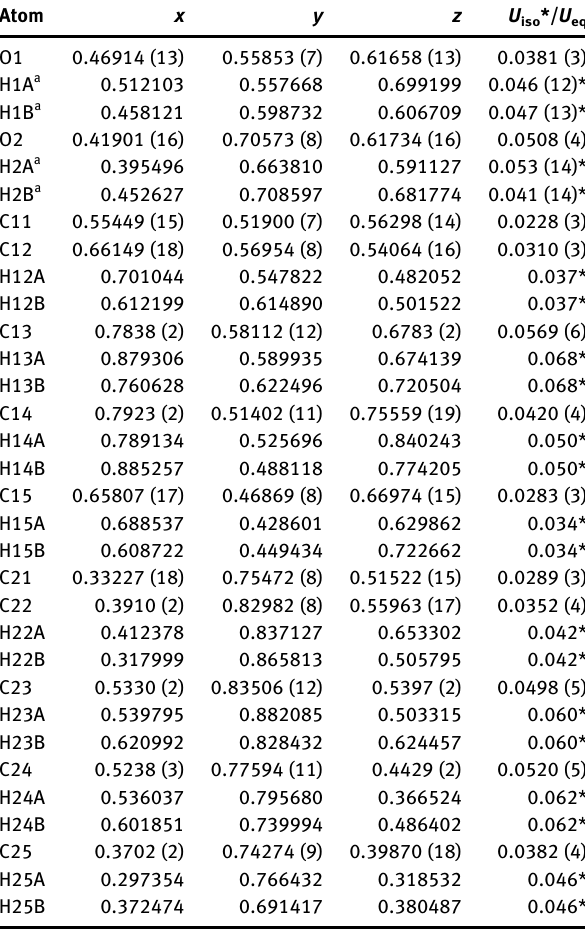
other compounds featuring two connected cycloalkyl moi- eties [17]. A conformational analysis of the fi ve-membered rings according to Cremer & Pople [18, 19] shows these to